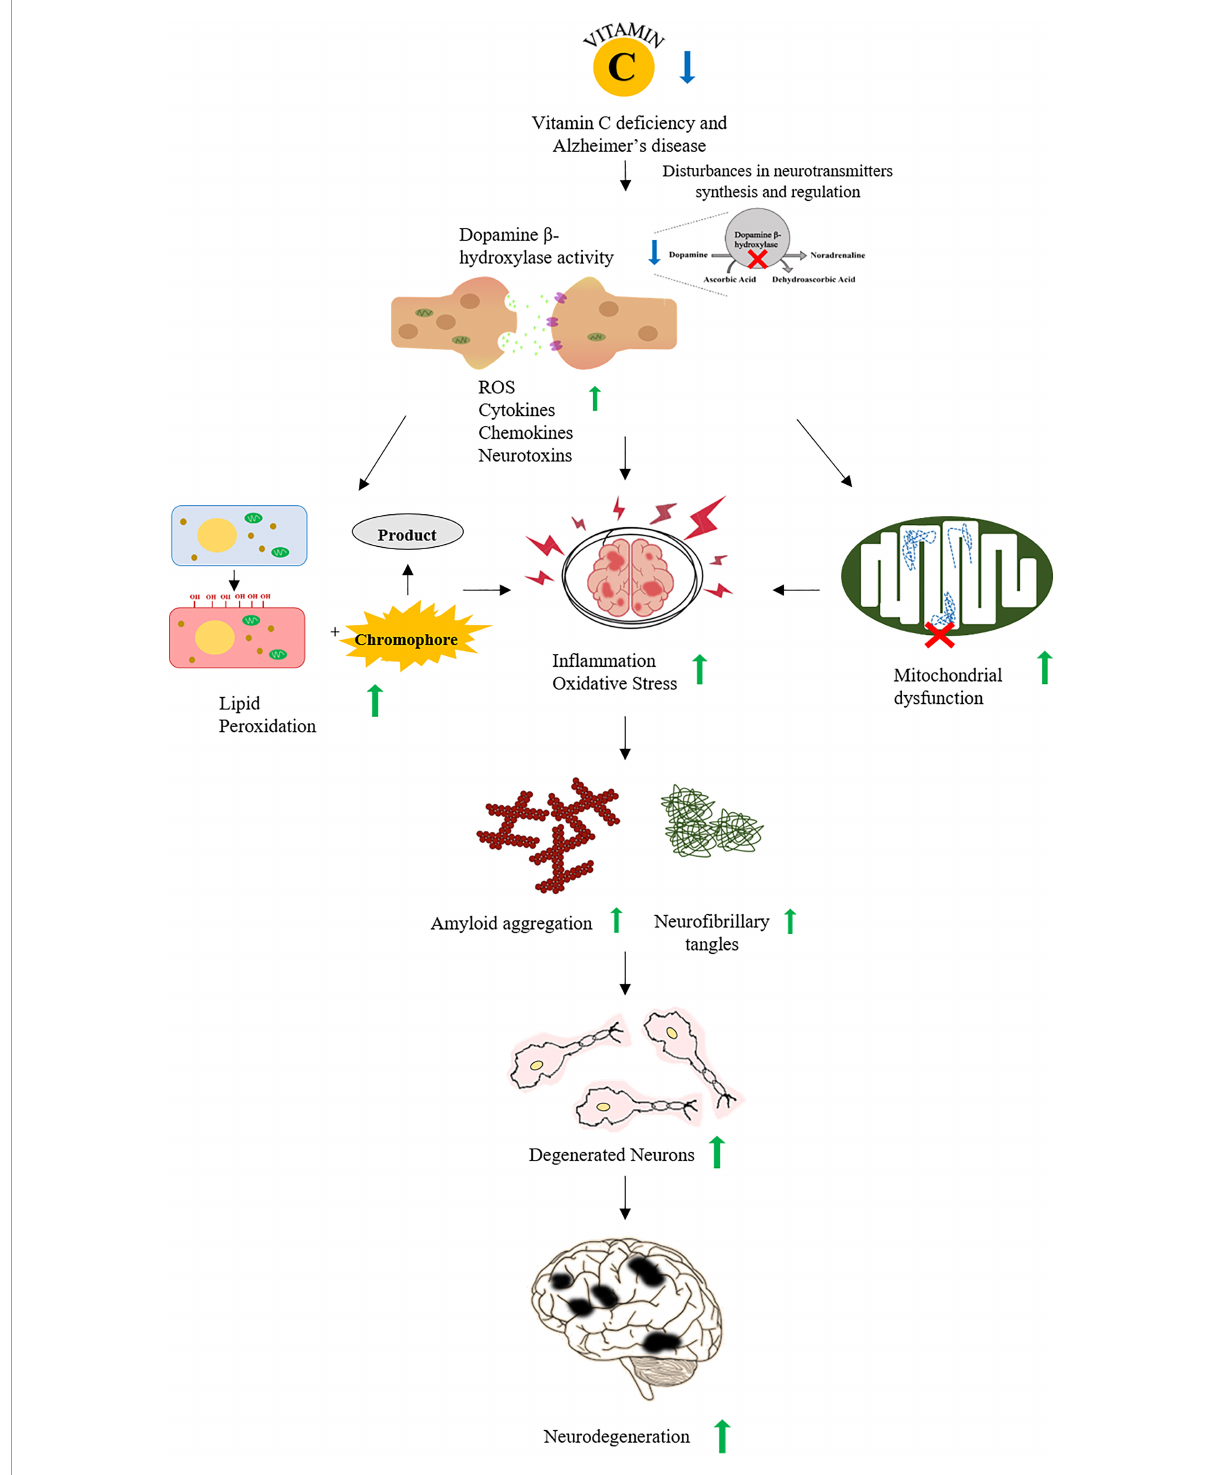
FIGURE1 A schematic representation of association between vitamin C and Alzheimer’s disease (AD). Vitamin C deficiency interrupts the synthesis and regulation of neurotransmitters increasing ROS, cytokines, and neurotoxins that lead to increased oxidative stress and inflammation. Oxidative stress also increases the accumulation of A β plaques and the formation of neurofibrillary tangles. All of these events promote the neurodegeneration observed in